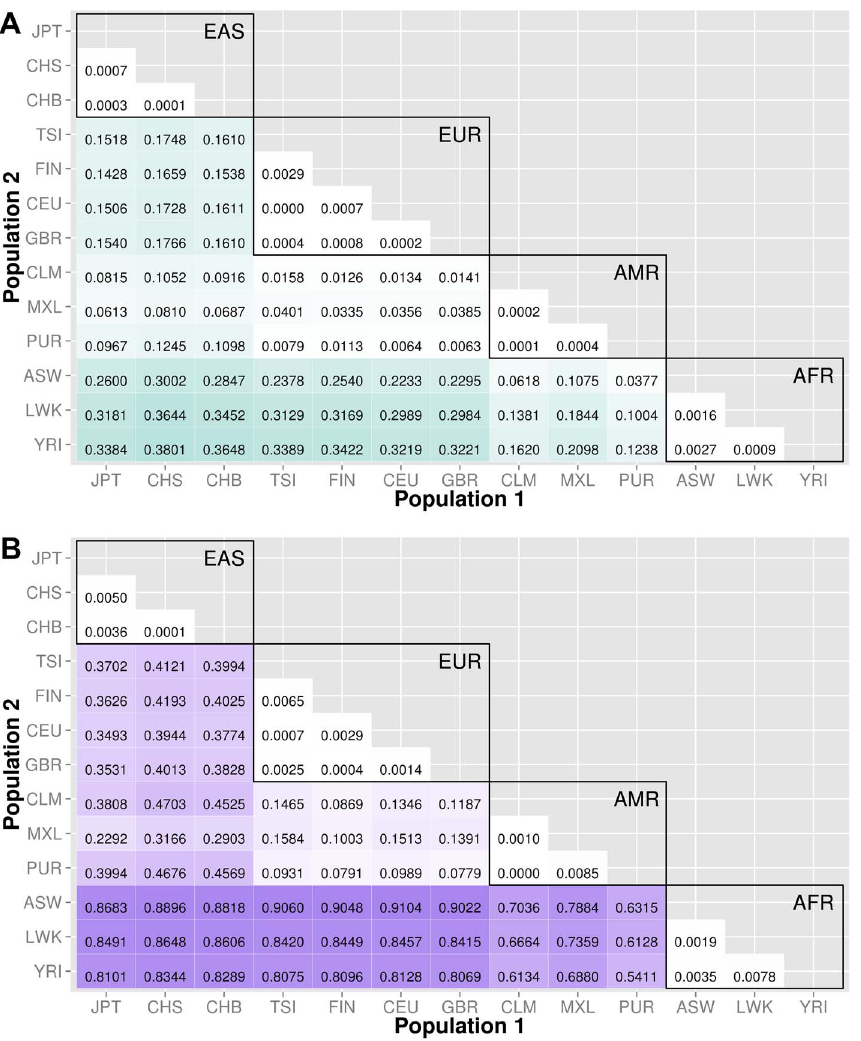
Figure 5. Proportion of significantly different bins in A) ORegAnno regulatory and B) pathway feature analysis. The abbreviations for the each population on are on the x and y-axes. The numbers in each block and the color intensity [0,1] indicate the proportion of significant bins (after Bonferroni correction) for the 1000 Genomes populations on each axis, where the darker the color, the higher the proportion of significant bins. In general, the x-axis is organized with African descent populations on the far right and increasing differentiation with regard to low frequency burden towards the left (i.e. populations of Asian descent have the highest proportion of significant bins compared to African descent groups). From more conserved regulatory regions to relatively large binned pathways, Figure 5A shows conservation in comparison to genic regions (Figure 3) and Figure 5B shows occasionally very high proportions of significant bins in parent pathway bins in comparison to genic regions (Figure 3).